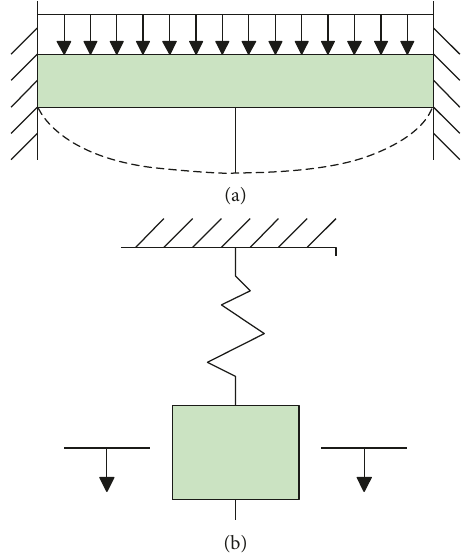
Figure 6: SDOF system. (a) Real structure. (b) Equivalent SDOF